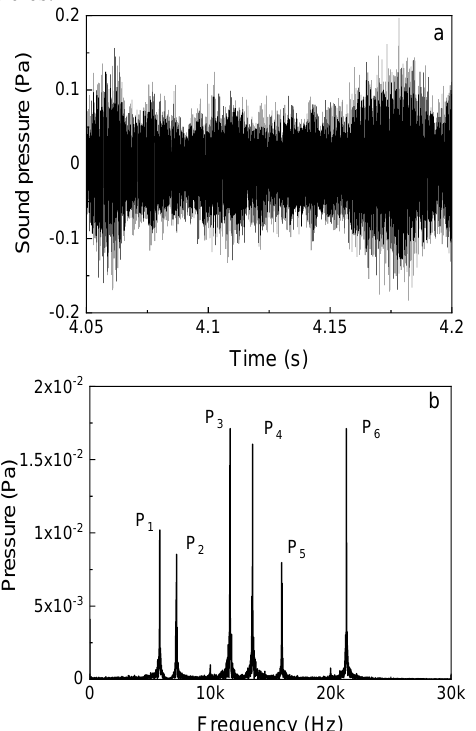
Fig. 4 Simulated AE signals of the drum (FL = 0.50, N = 45 rpm ): (a) time domain; and (b) frequency spectrum.